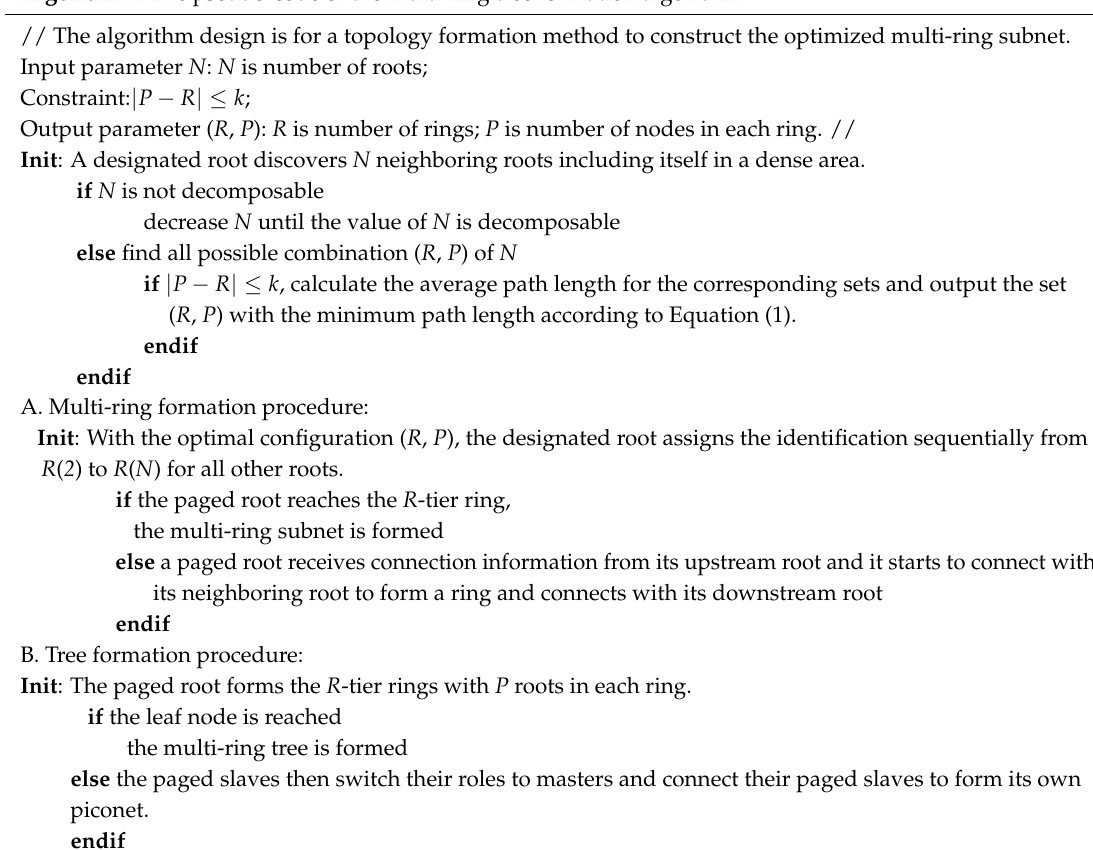
Figure 3. An illustrated example of the multi-ring tree network. Algorithm 1 The pseudo-code of the multi-ring tree formation algorithm